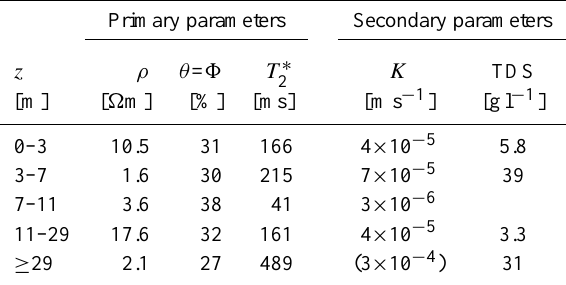
Table 3. Retrieved hydraulic parameters for sounding SKD. Primary parameters Secondary